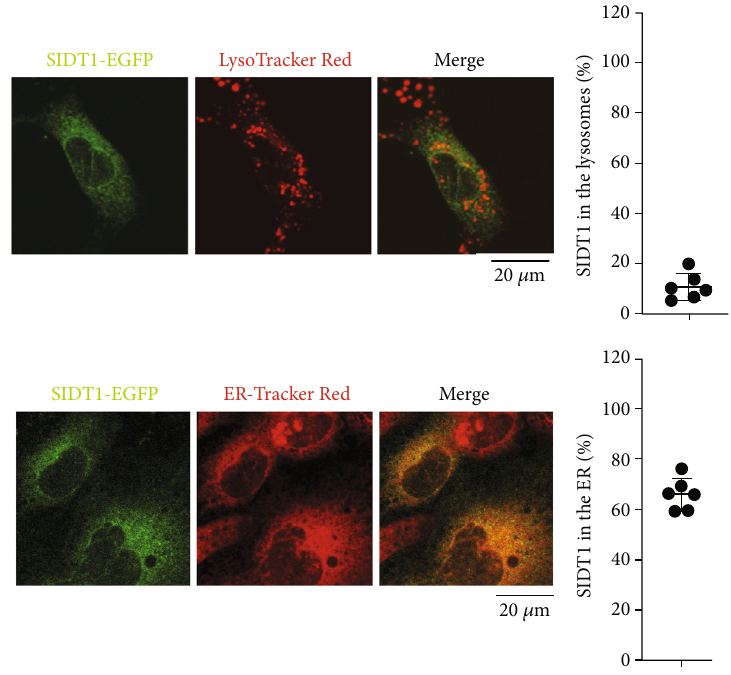
Figure 4: Localization analysis for SIDT1. MEFs were transfected with pEGFP-N1-SIDT1 and cultured for 24 hours. Then, MEFs were stained with LysoTracker Red or ER-Tracker Red, and fl uorescence images were visualized using a confocal microscope. The colocalization rates were quanti fi ed with ImageJ. Error bars indicate s.d. ( n = 6